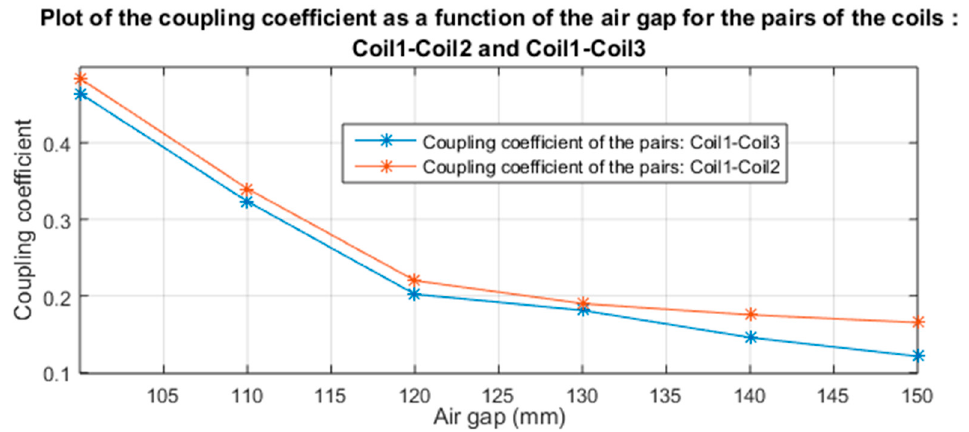
Figure 17. Evolution of the coupling coefficient for the pairs of coils, Coil1–Coil2 and Coil1–Coil3, as a function of the air gap.